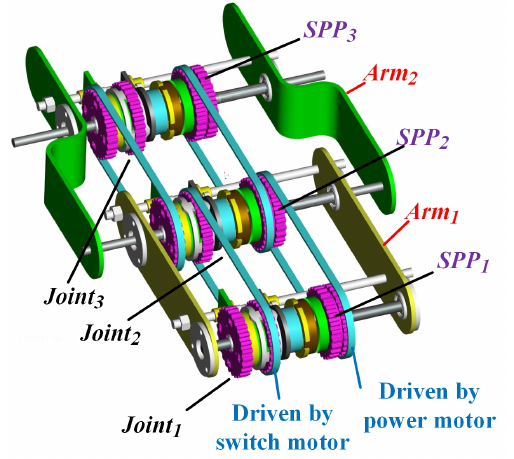
Figure 10. The Joint 2 is in switched off status before being driven. SPP 1 – SPP 3 is Part 13 (power pulley) of the PSU of Joint 1 – Joint 3 . Arm 2 will be driven by Joint 2 relative to Arm 1 .